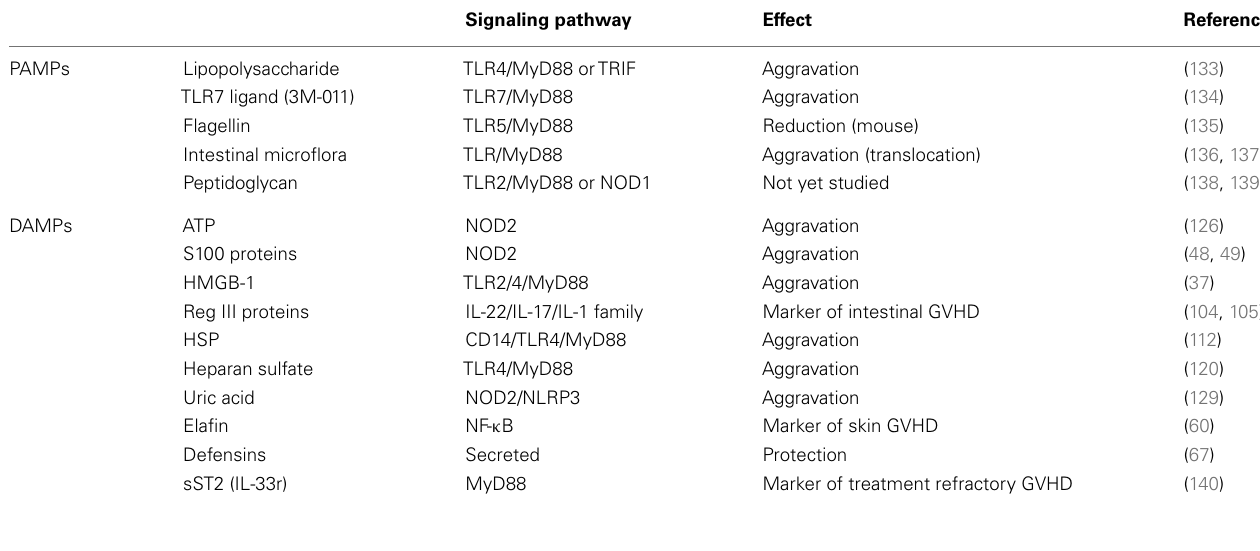
Table 1 | GVHD-related PAMPs and DAMPs along with their signaling pathways and effects in GVHD